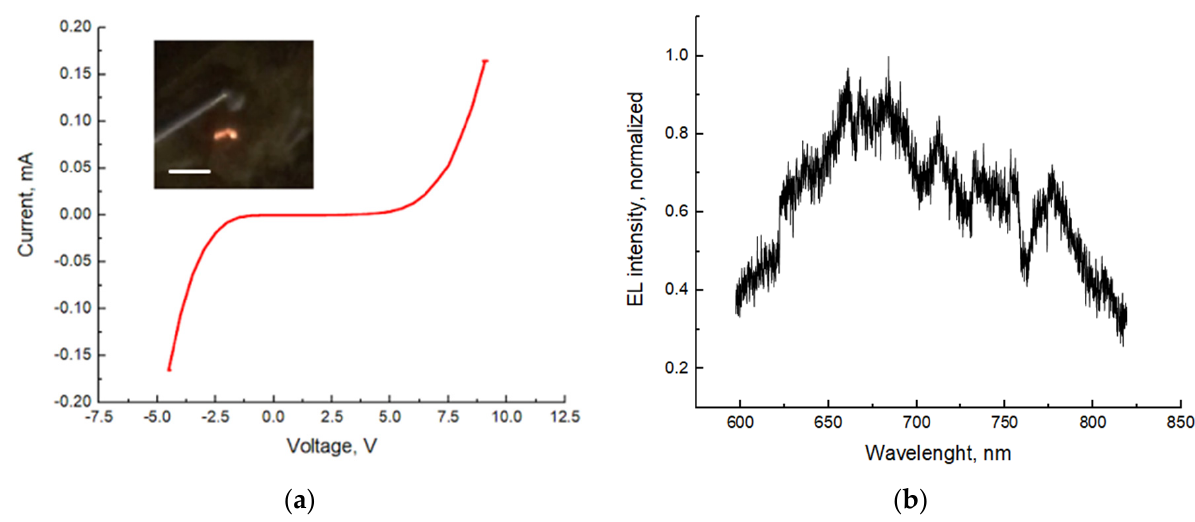
Figure 6. I-V curve ( a ) and EL spectrum ( b ) of a representative flexible LED. The inset in ( a ) demonstrates a photo of the working device, the scale bar is 3 µm.